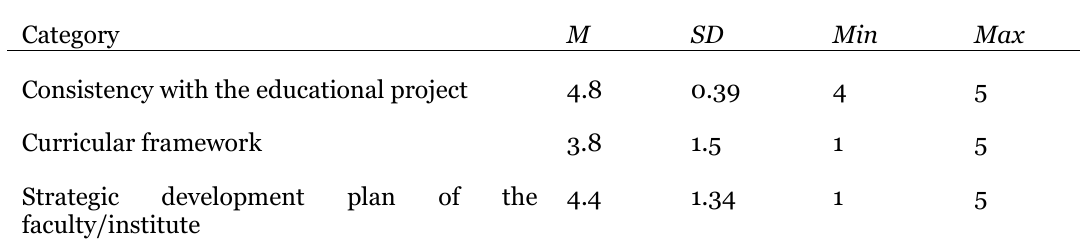
Institutional Dimension’s